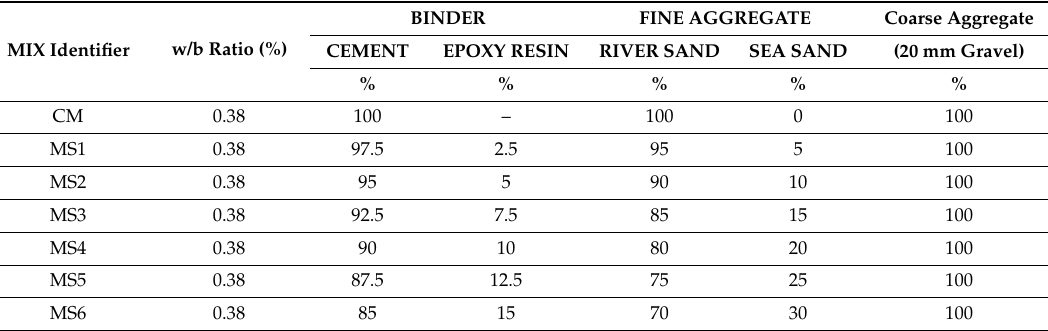
Table 2. Composition of the concrete mixes showing the proportion of ingredients (% by weight).